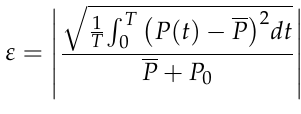
Figure 11. View of internal flow of scheme B. ( Ⅰ ) Streamline, ( Ⅱ ) Relative velocity vector, ( Ⅲ ) Turbulence vortex frequency and ( Ⅳ ) Turbulence kinetic energy.